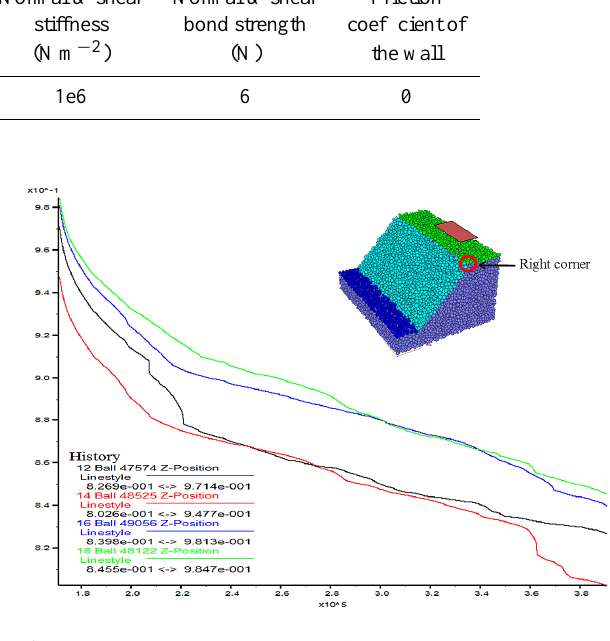
Figure 12 Vertical position history for balls at the right corner of crest